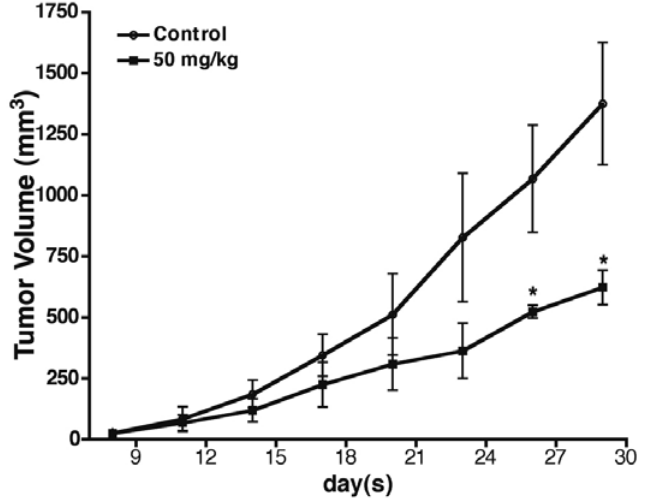
Figure 7. Effect of baicalin on the growth of colon cancer in the human SW620 CRC xenograft model. Xenograft experiments were performed as stated in the experimental section. Points, mean tumor volumes; bars, SE. Daily i.p. treatment of mice in the two groups: vehicle (n = 5) and 50 mg/kg baicalin (n = 5). * p <